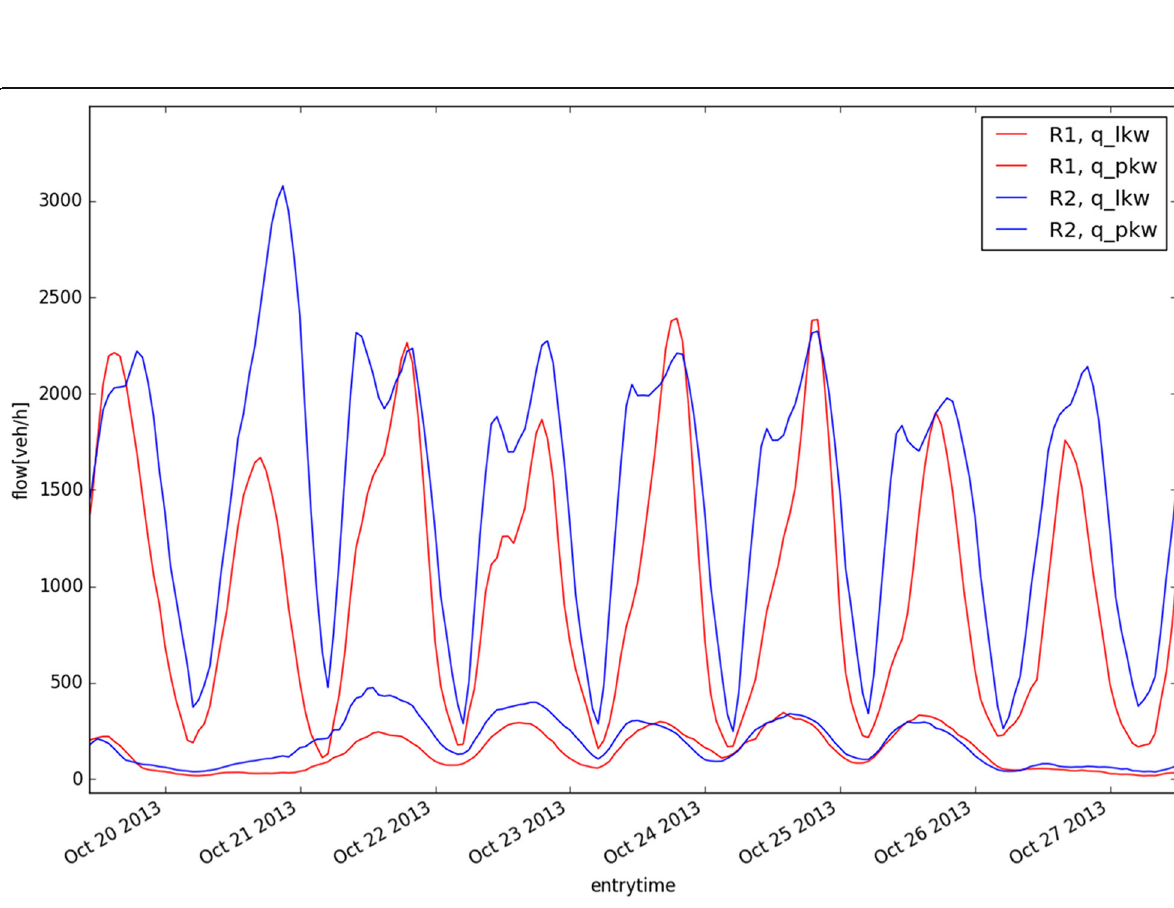
Fig. 8 Typical hydrograph of the highway